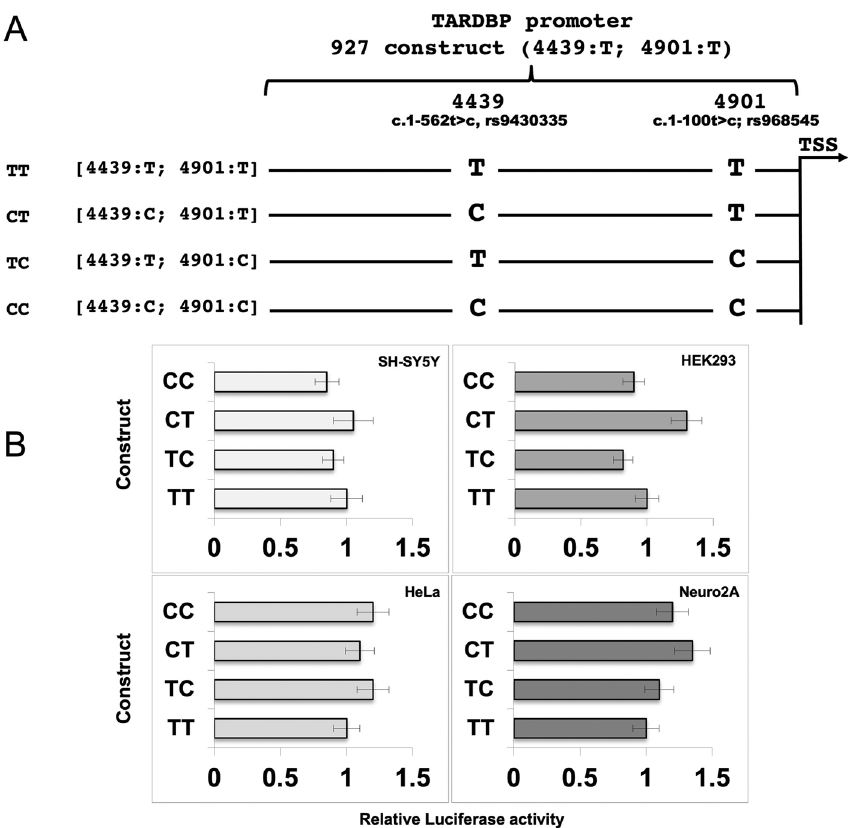
Figure 6. Effects of ALS-related SNPs on TARDBP promoter activity. (A) Schematic representation of the human TARDBP promoter variants. The diagram depicts the wild type and the mutated promoter sequences used for the luciferase assay. The mutated nucleotides (and their positions) are indicated. (B) Luciferase activity of TARDBP promoter variants in different cell lines (SH-SY5T, HEK293, HeLa and Neuro 2A). Luciferase activity (normalized against Renilla) is expressed as-fold against transfections of the haplotype [4439:T; 4901:T] (= 1). Data are mean (± SD) of three independent assays/cell line. The mean values did not differ to a statistically significant extent (p ≥ 0.05, one way ANOVA with Tukey